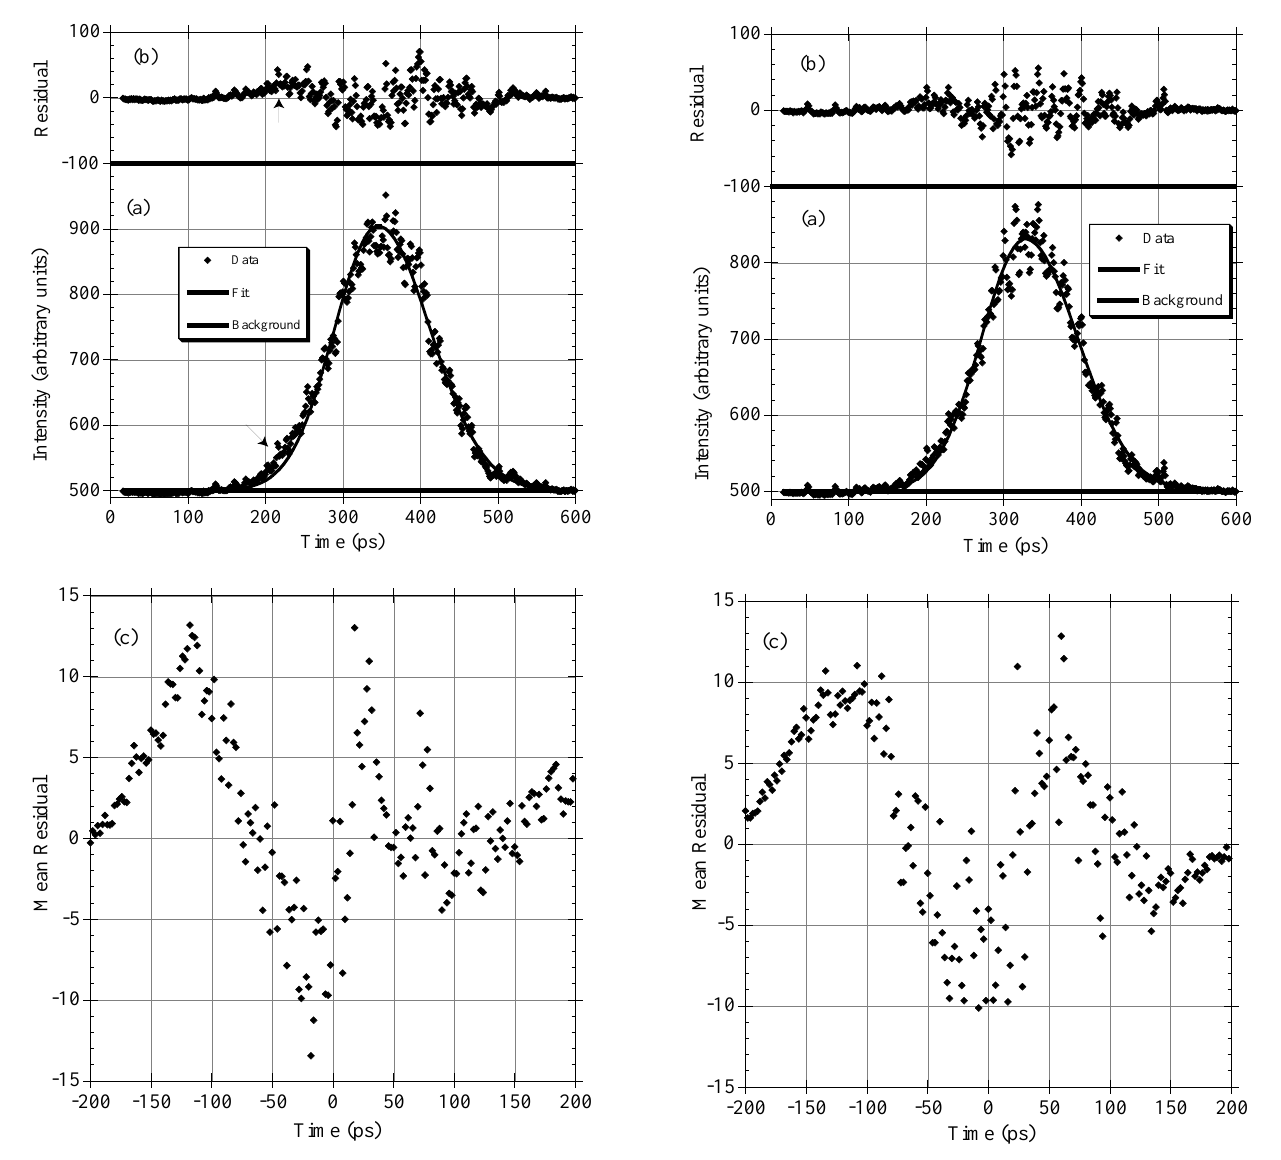
FIG. 18. A single data acquisition of the longitudinal bunch distribution fit to the mean stable distribution when the phase of the rf voltage is modulated at (a) 1 10 dBm. (b) The residual between the single data acquisition and the mean stable distri- bution. The mean residual for the data set is plotted in (c). The arrows in (a) and (b) depict the onset of the sextupole mode oscillation in the bunch distribution.